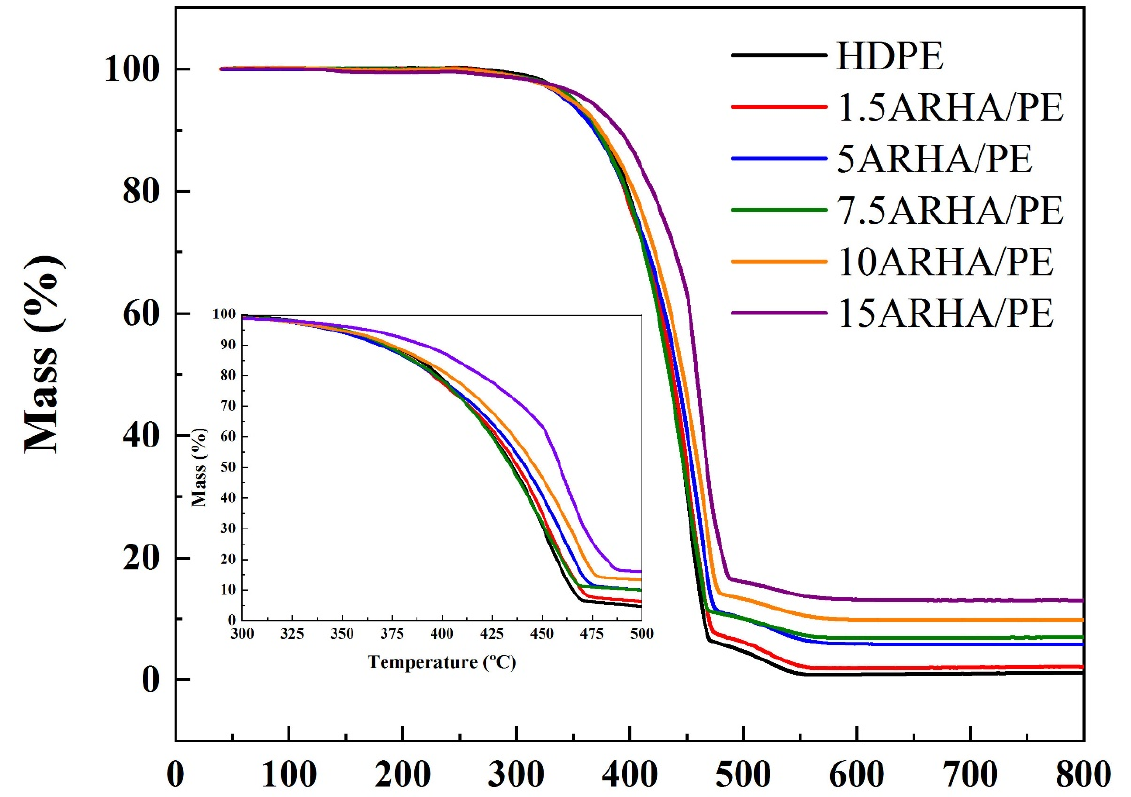
Figure 8. TGA curves in air flow for pure HDPE and its composites.